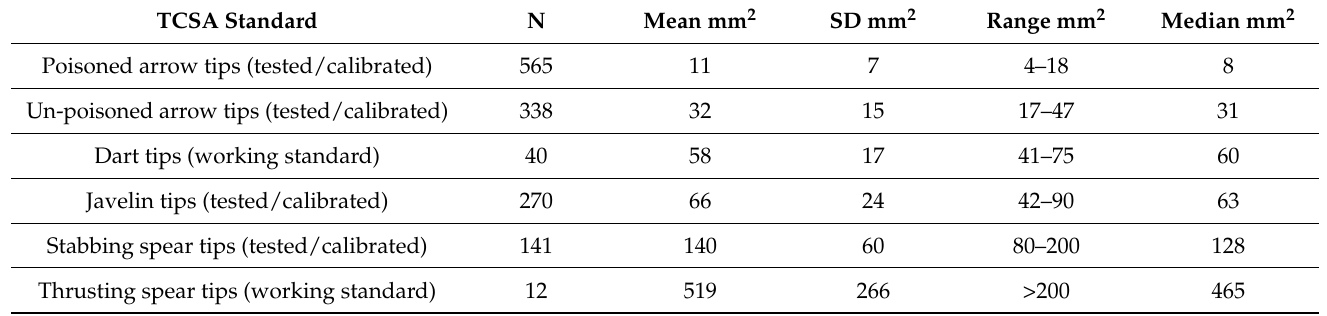
Table 1. Newly calibrated TCSA standards for six weapon types used by recent hunter-gatherers